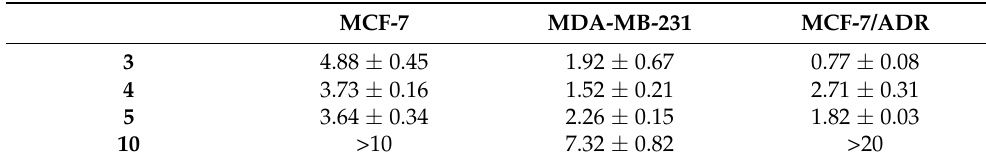
Figure 5. Fluorescence observation of subcellular localization of OblA Au , OblB Au , OblC Au and OblD Au . a/b/c/d–i : multiple nuclei localization by DAPI; a/b/c/d–ii : eGFP-OblA Au , eGFP-OblB Au , eGFP-OblC Au and eGFP-OblD Au localization, respectively; a/c/d–iii and b–v : bright fields. a-iv : merge of a–i , a–ii and a–iii ; b–iii : localization of Mito-Tracker Red CMXRos; b–iv : merge of b–i , b–ii , b–iii and b–iv ; c–iv : merge of c–i , c–ii and c–iii ; d–iv : merge of d–i , d–ii and d–iii . Table 1. The IC 50 values ( µ M) of compounds 3 – 5 and 10 on MCF-7, MDA-MB-231 and MCF-7/ADR cell